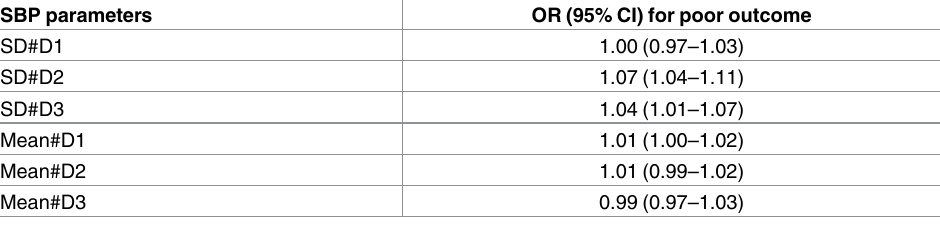
Logistic regression models were used to calculate the odds ratios (95% confidence interval), with adjustments for age, time to arrival, recanalization therapy, hypertension, diabetes, atrial fibrillation, baseline NIHSS score, and stroke